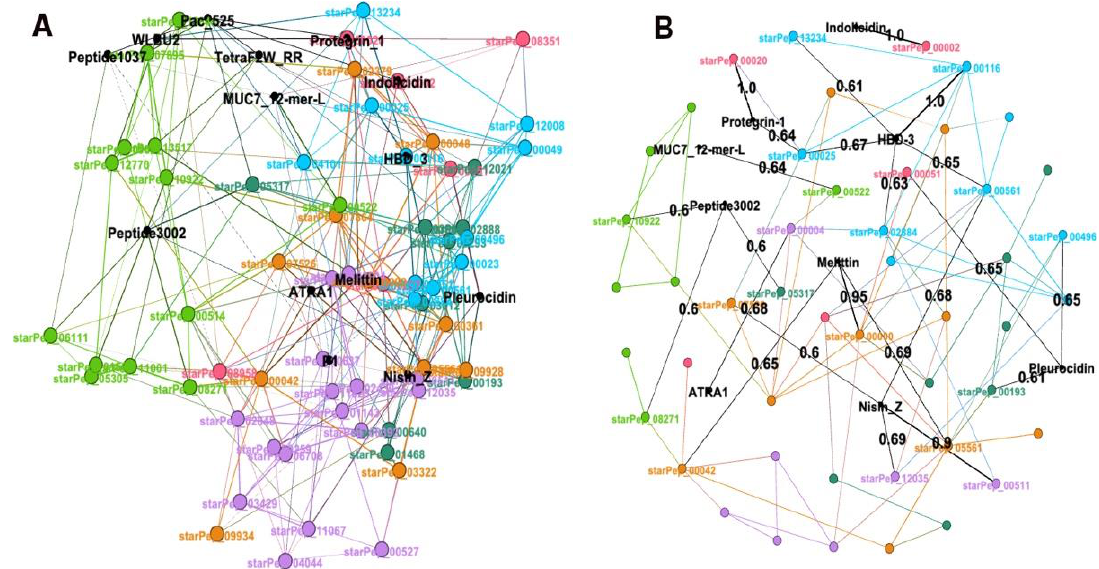
Figure 9. Visual mining of the 14 ABFPs corresponding to 14 classes of mode of actions on the chemical space of ABFPs. ( A ) Overlapping the 14 representative ABFPs on the set integrated by 66 ABFPs using HSPN. Peptide communities are represented by different colors, while the 14 ABFPs nodes/labels are highlighted in black color. ( B ) Mapping of the representative ABFPs with similarities higher than 0.60 within the antibiofilm HSPN using the Fruchterman – Reingold layout.